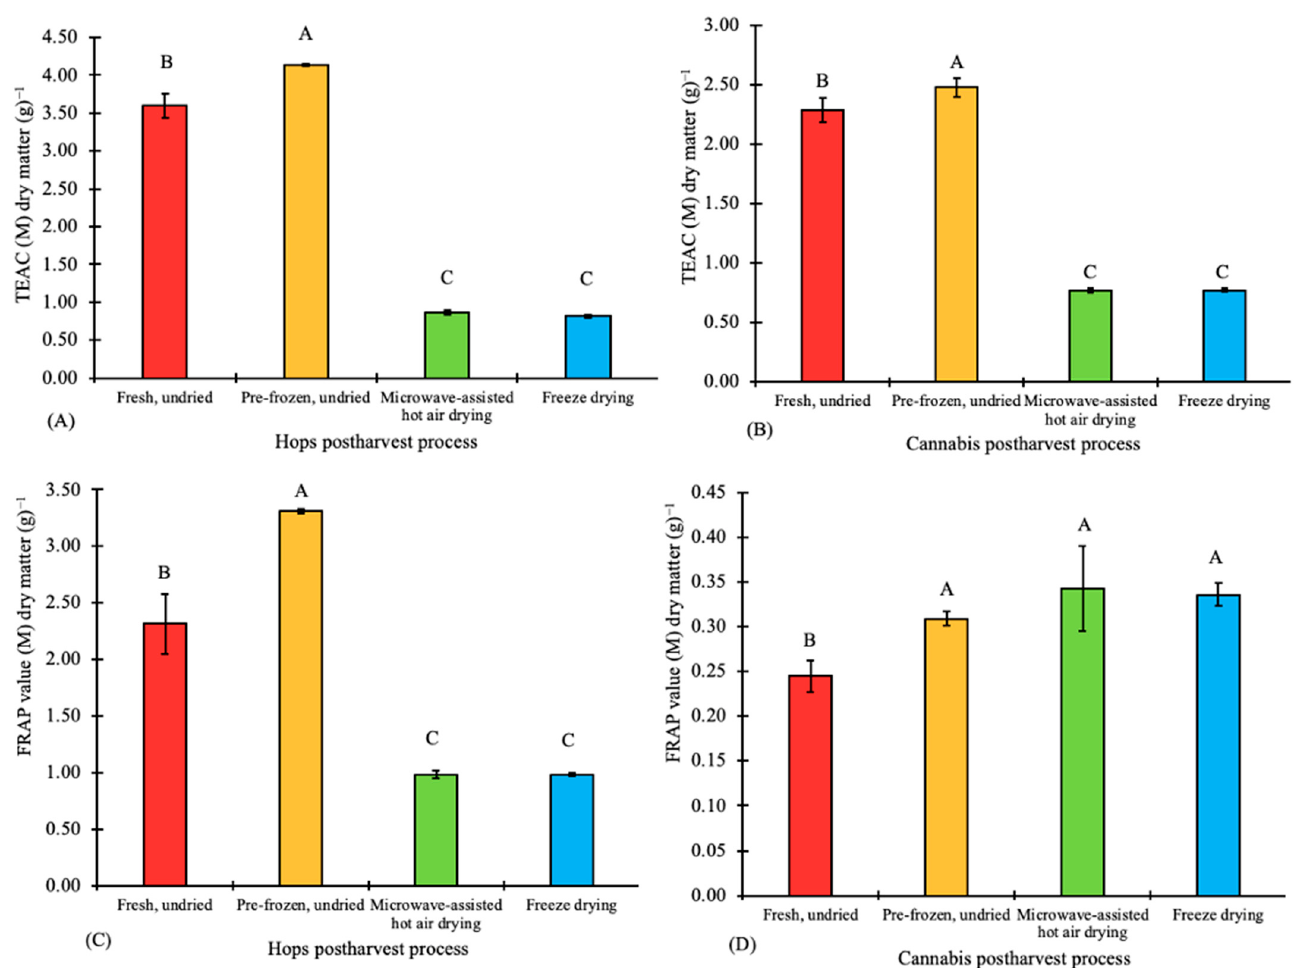
Figure 3. Total antioxidant activity in extracts from hops ( Humulus lupulus ) and cannabis ( Cannabis sativa ) inflorescences using the DPPH ( A,B ) and FRAP ( C,D ) assays. Bars with the same letter are not significantly ( p < 0.05) different. DPPH: 2,2-diphenyl-1-picrylhydrazine; FRAP: Ferric reducing antioxidant power; TEAC: Trolox equivalent antioxidant activity. values by 13% (DPPH assay) and 29.9% (FRAP assay) for hops, and by 7.7% (DPPH assay) and 19.4% (FRAP assay) for cannabis (Figure 3). DPPH assays used for this study show hops by 79% and 80.2%, respectively, compared to pre-frozen, undried samples. A similar by 70.1% and 70.4% under freeze-drying and microwave-assisted hot air drying,